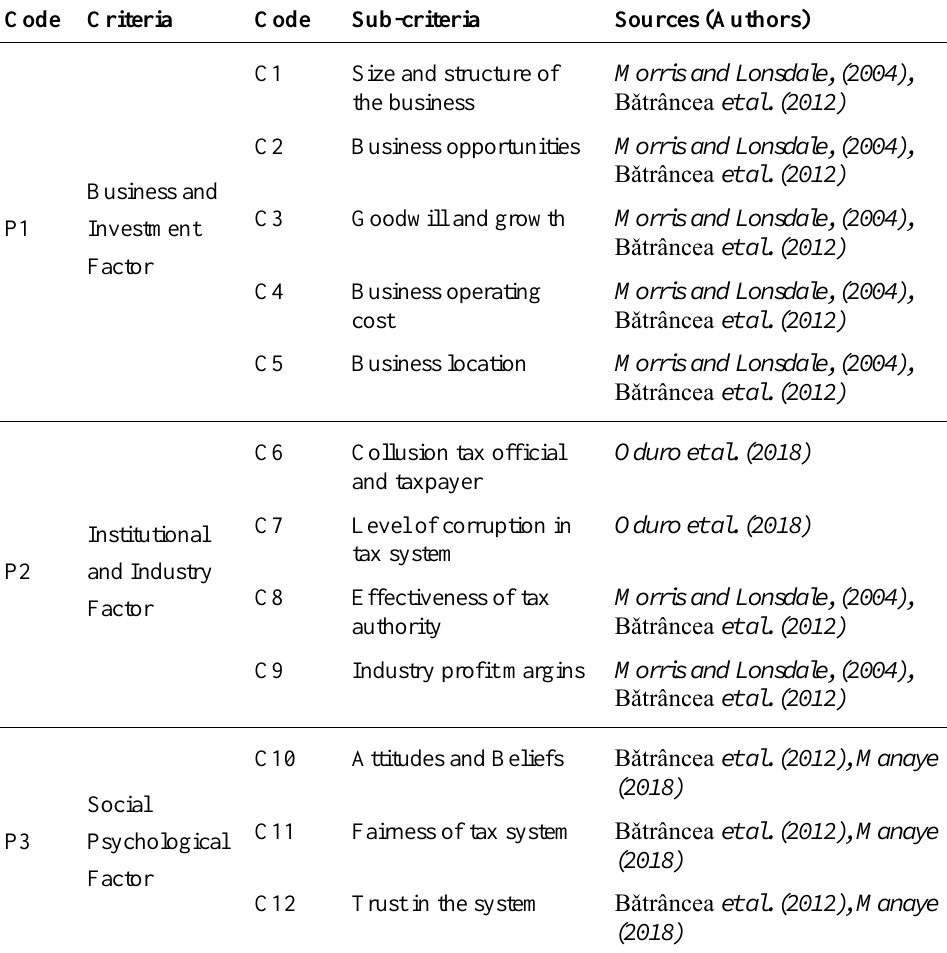
Table 1: Measures of Tax Compliance and Their Dimensions